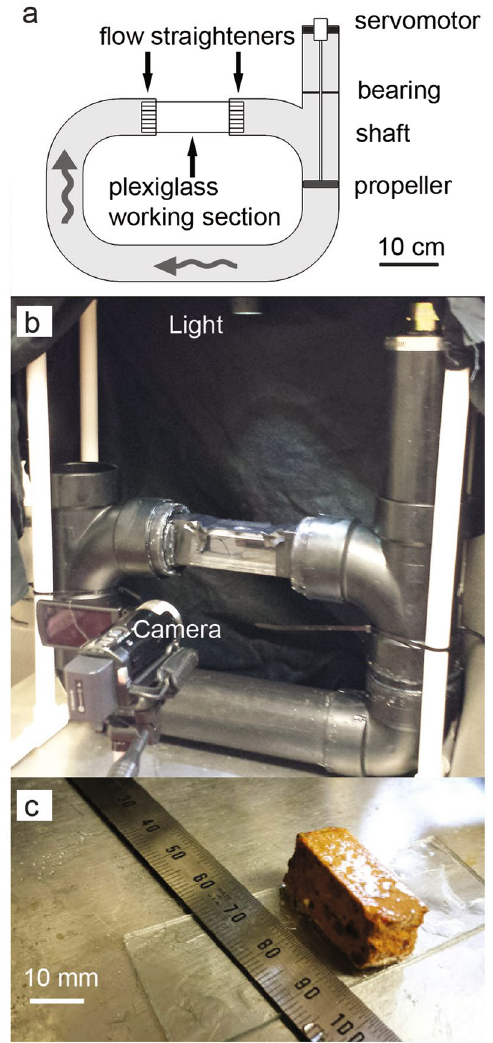
Figure 1. The oscillating flume tank for coral larval swimming tests, which was designed to replicate water motion from the reef (see Methods for a full description). ( a) Schematic of the oscillating flume tank. ( b ) Picture of flume set-up with light and high-speed camera. ( c ) Picture of a block treatment settlement tile (1 × 2.5 × 1 cm, L × W × H) mounted on a glass